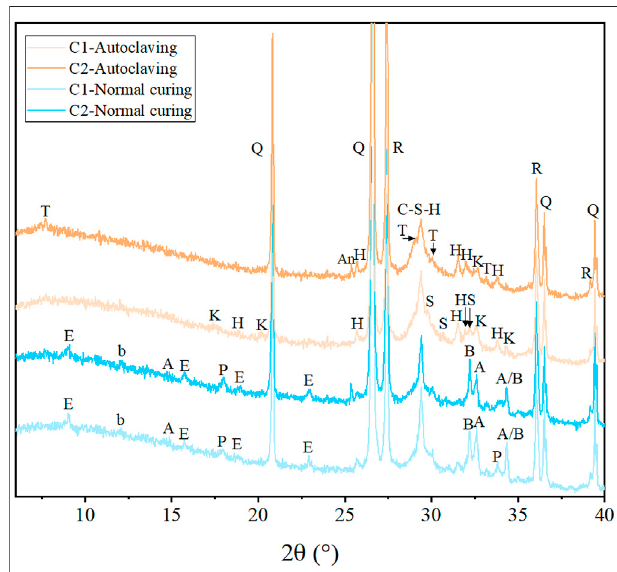
FIGURE 3 | Diffraction patterns of the samples after different treatments (Q: quartz, A: alite, B: belite, b: calcium aluminoferrite, E: ettringite, P: portlandite, T: tobermorite, S: scawtite, H: hydroxylellestadite, K: katoite, R: